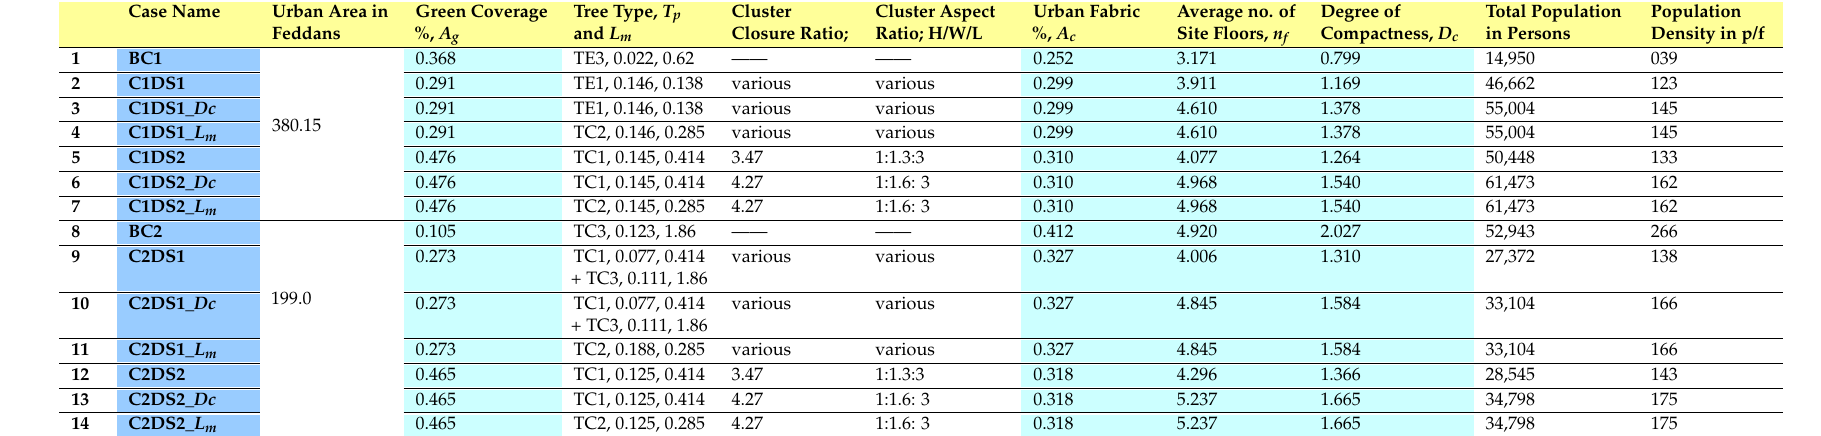
Table 2. Housing design and land use statistics used in modeling in